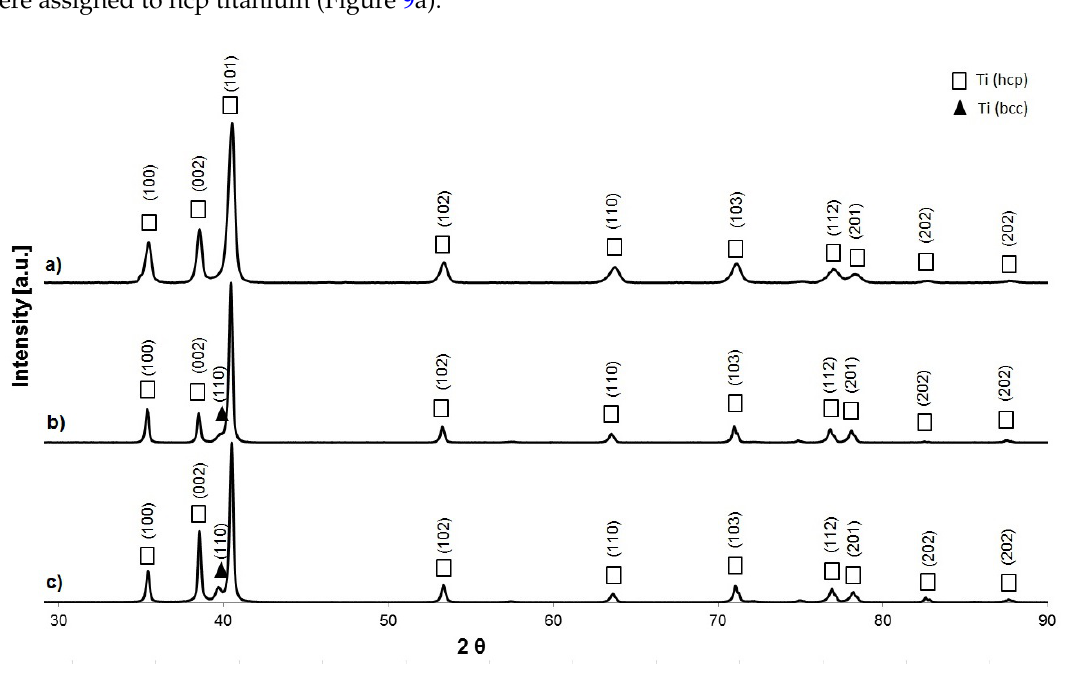
Figure 9. The XRD (X-ray diffraction) patterns for Ti-6Al-4V alloy obtained in the SLM ( a ), EBM ( b ) and heat-treated and annealed sheet ( c ).